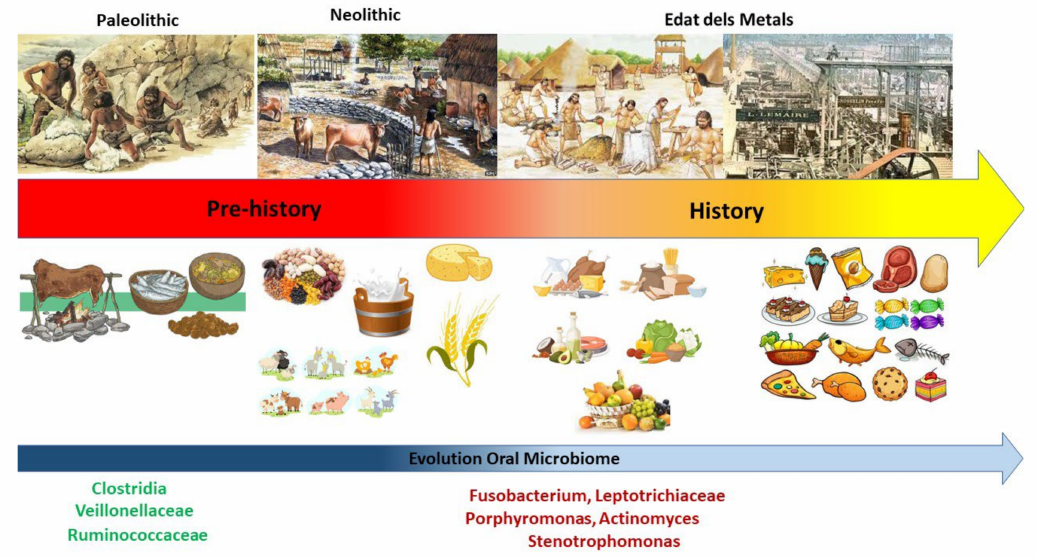
Figure 3. Evolution of diet and corresponding